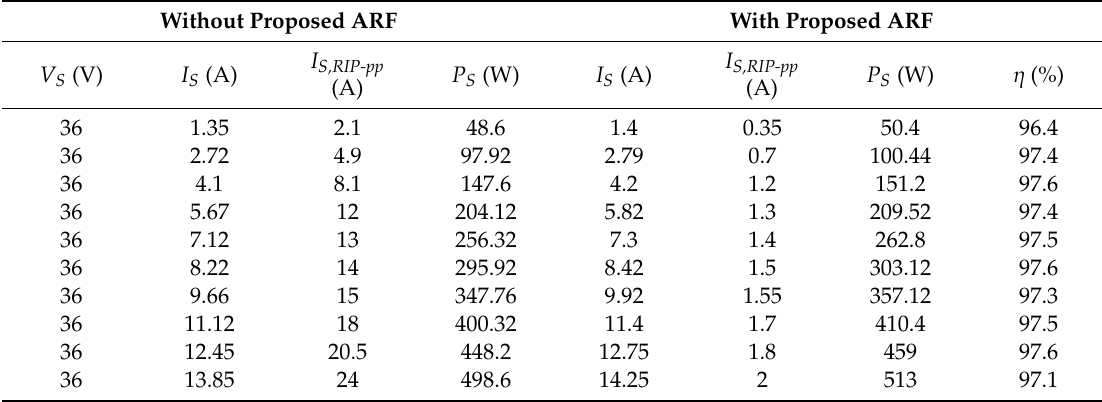
Figure 18. Conversion efficiency of the proposed method under different loads.